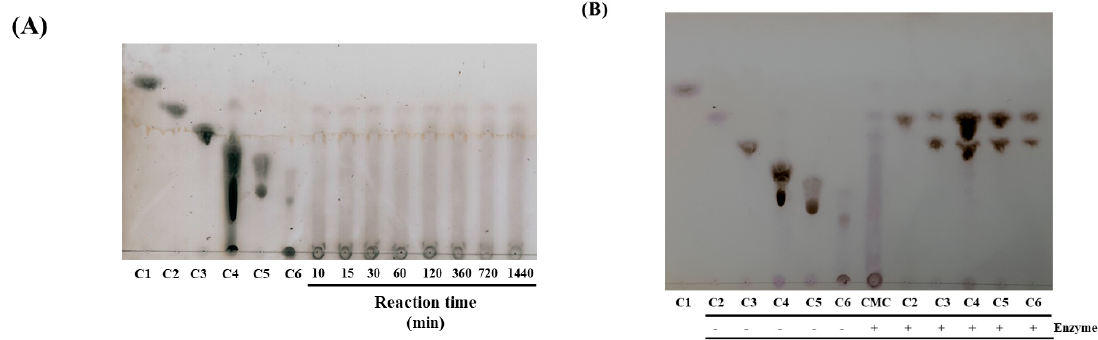
Figure 5. Analysis of CelA J93 enzyme hydrolysates of various substrates by thin layer chromatography. ( A ) Chromatogram of the carboxymethylcellulose hydrolysate produced by CelA J93 according to reaction time at pH 7.5 and 37 ◦ C. The presence of smeared bands under the cellobiose band